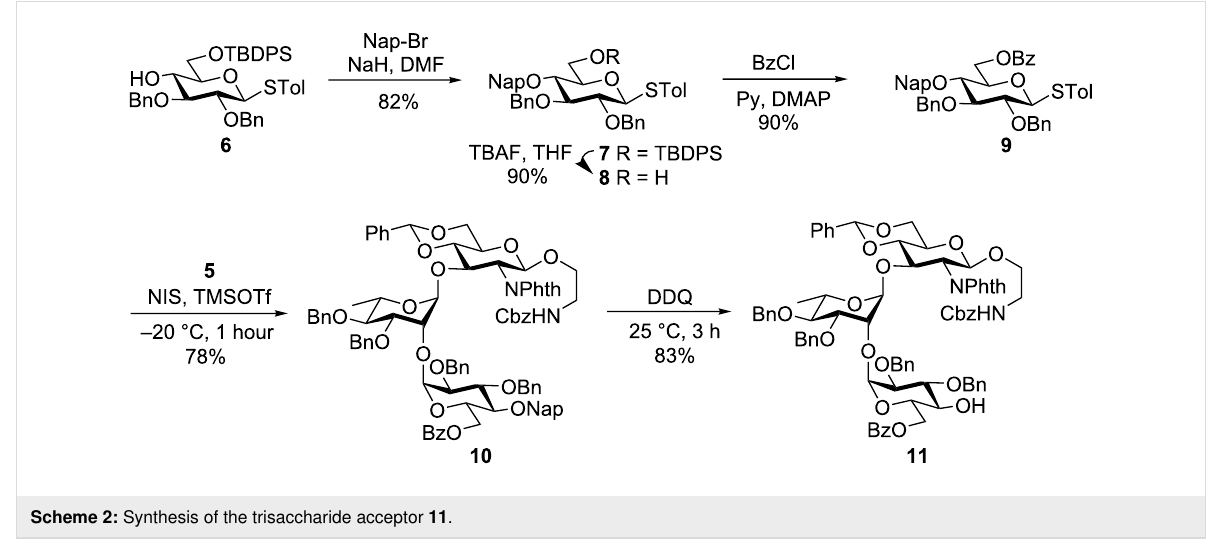
Scheme 2: Synthesis of the trisaccharide acceptor 11 .